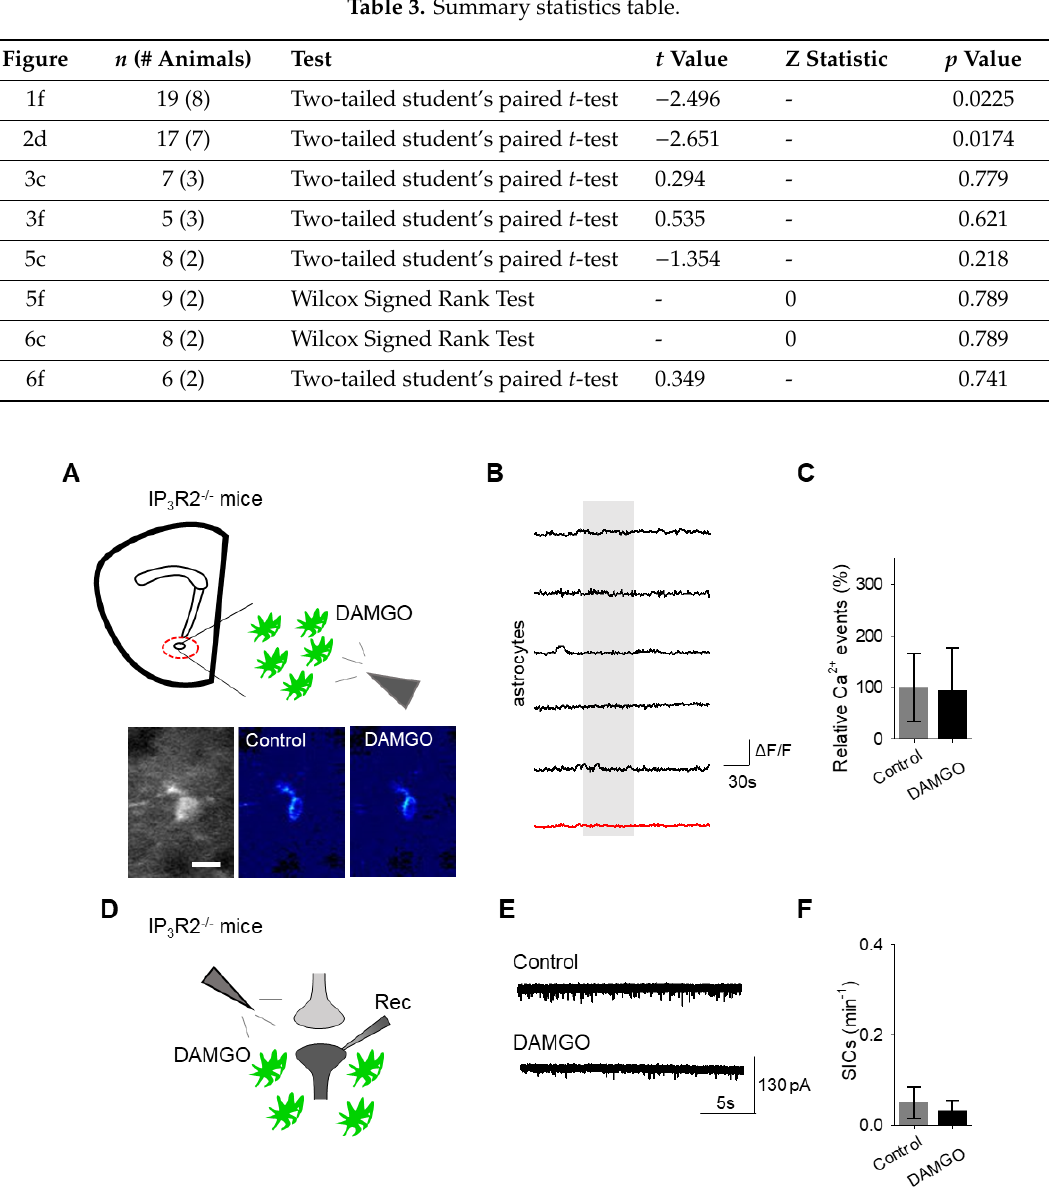
Figure 6. IP 3 signaling in astrocytes mediates DAMGO actions on astrocytes and neuronal slow inward currents. ( A ) Scheme of experimental approach and pseudocolor images showing the fluorescence intensities of a GCaMP6-expressing astrocytes in the nucleus accumbens before and after DAMGO application in slices from IP 3 R2 − / − mice. ( B ) Calcium traces of astrocytes (gray shading indicates DAMGO application; red trace = average) in slices from IP 3 R2 − / − mice. ( C ) Relative calcium events before (control) and after DAMGO application in slices from IP 3 R2 − / − mice. ( D ) Scheme of the electrophysiology experimental approach in slices containing the nucleus accumbens from IP 3 R2 − / − mice. ( E ) Representative electrophysiology recordings in control conditions and after DAMGO application in slices from IP 3 R2 − / − mice. ( F ) SICs per minute before (control) and after DAMGO application in slices from IP 3 R2 − / − mice. Data are expressed as mean ± SEM, scale bar = 10 µm.